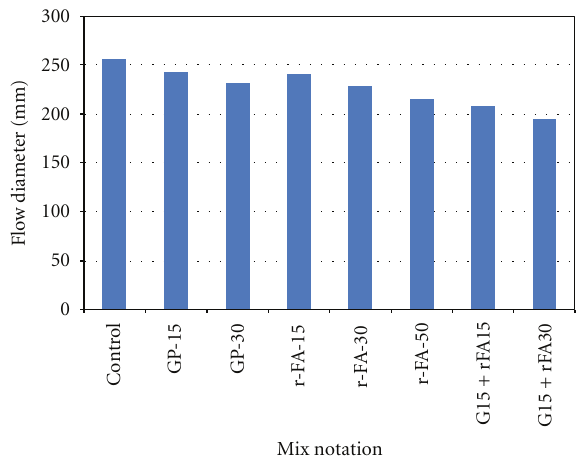
Figure 1: Flow diameter of concrete.